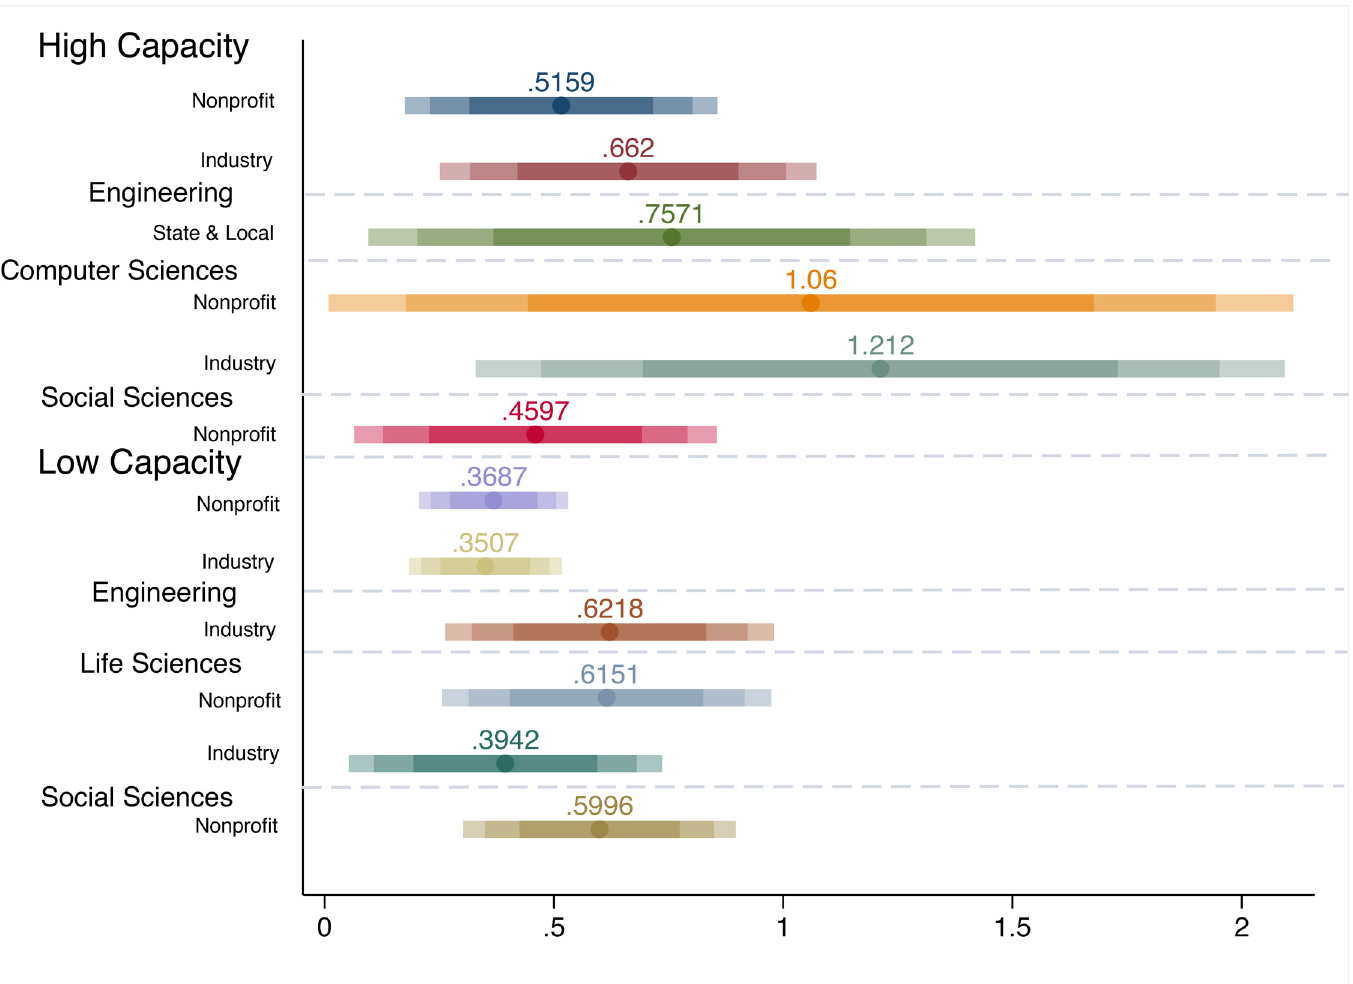
Fig 3. Robust Federal R&D Elasticity Confidence Intervals by Field Research Capacity, Broad Academic Division, and Non-Federal Source of Funding. Notes : Confidence intervals of elasticities from Eq 1 estimations are presented along the x-axis (95%, 90%, and 75%). Elasticity values are presented only if the results for the primary outcome – federal R&D funding – are efficient and consistent to the following additional model specifications: the alternate dynamic panel model (Eq 4), and the fixed effects model (Eq 2). The y-axis reports the sample stratifications with the respective outcome listed for each confidence interval. The dashed horizontal lines delimit the